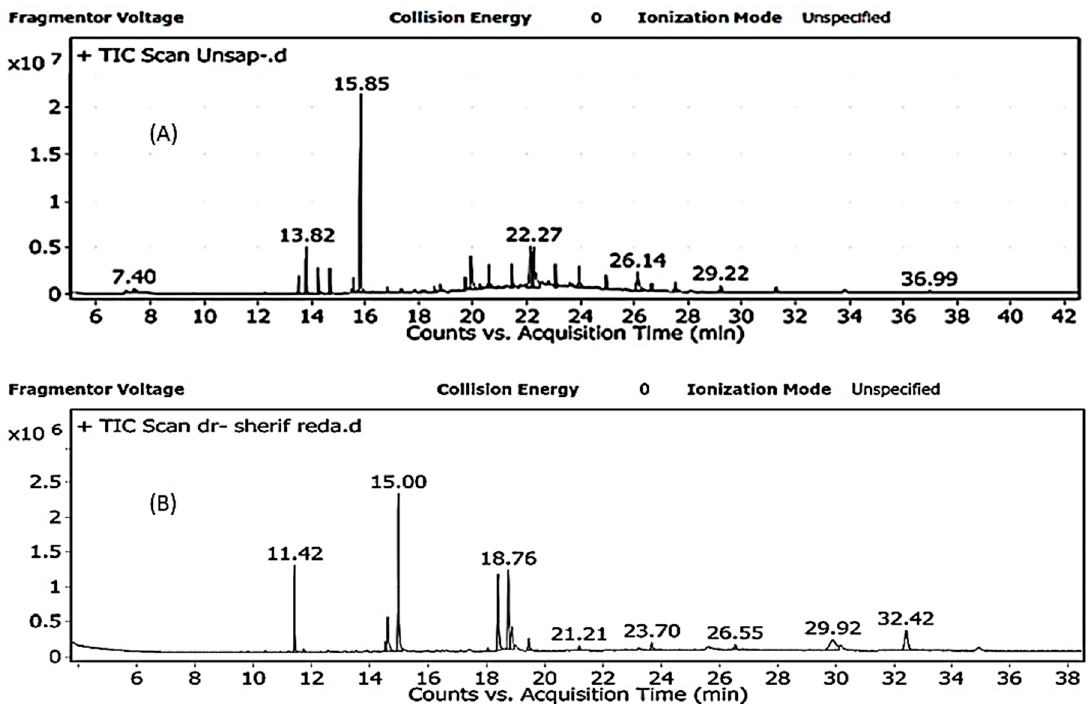
Figure 1. GC/MS of ( A ) USM with heptadecane as the main hydrocarbon and ( B ) fatty acid methyl esters (FAME) with palmitic acid as the main FA of SP .